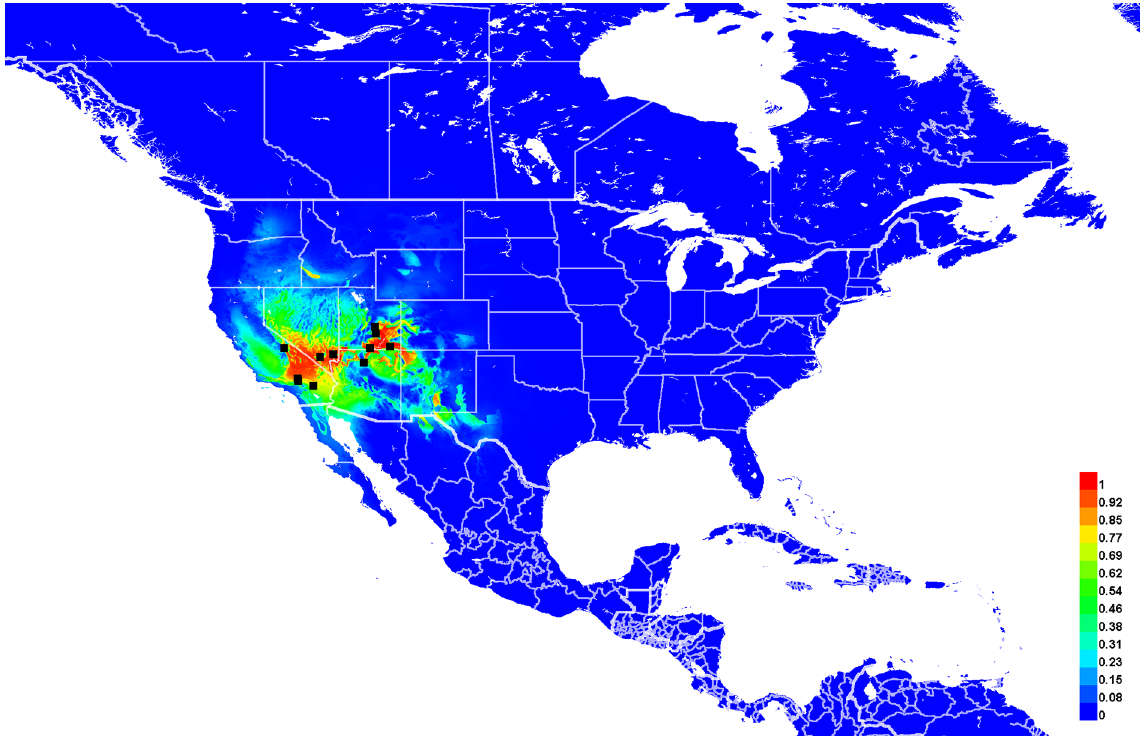
Fig. 63. Georeferenced collection records of Lasioglossum ( D. ) miltolepoides sp. nov. (black squares) and predicted distribution by maximum entropy ecological niche modeling in Maxent (colour shading). Warmer colours indicate higher cloglog probability of